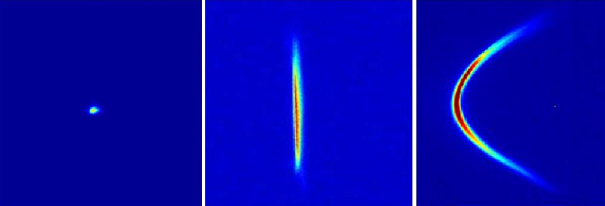
FIG. 20. (Color) OTR image with rf deflector ‘‘OFF’’ (left) and ‘‘ON’’ (middle), to measure slice emittance. YAG screen after a bend (right) with deflector ON, reveals longitudinal phase space directly on the